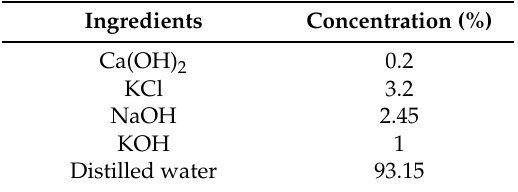
Table 2. The composition of the simulated pore solution.